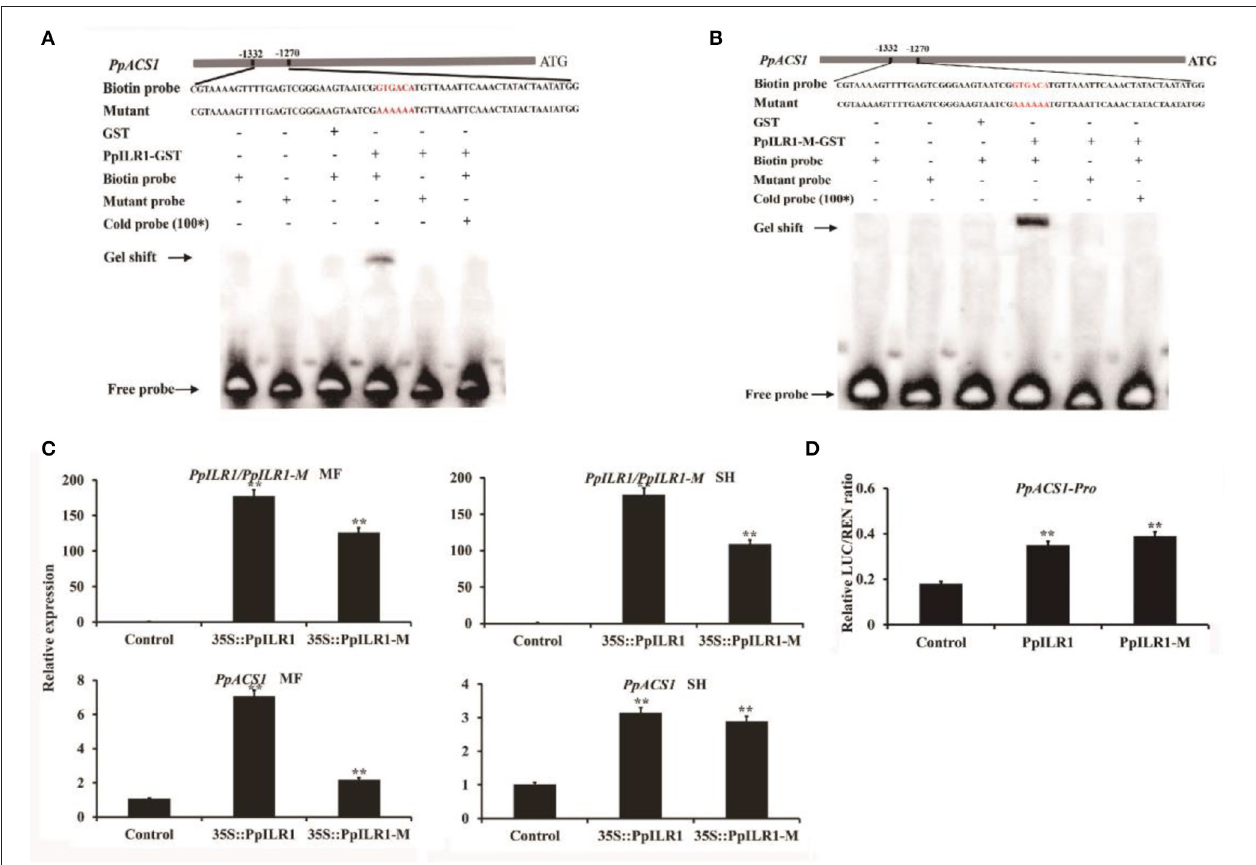
FIGURE 4 | PpILR1 and PpILR1-M activate transcription of PpACS1 . (A) Electrophoretic mobility shift assay (EMSA) showing that PpILR1 binds to the GTGACA motif in the PpACS1 promoter fragments, but not to the poly-A mutant fragment. (B) EMSA showing that PpILR1-M binds to the GTGACA motif in the PpACS1 promoter. (C) Transient overexpression of PpILR1 and PpILR1-M in MF- and SH-type peach fruits enhances the transcript levels of PpACS1 . Transcript levels of PpILR1 , PpILR1-M , and PpACS1 in peach fruit infiltrated with the empty vector (control), 35S::PpILR1, and the 35S::PpILR1-M vector. (D) Dual-luciferase reporter assay analysis showing that PpILR1 and PpILR1-M activate the promoter of PpACS1 . Agrobacterium tumefaciens harboring PpILR1 / PpILR1-M or PpACS1 promoter-driven firefly luciferase (LUC) reporter plasmids were infiltrated into tobacco leaves. Significantly higher LUC:REN ratios were obtained with the PpILR1 / PpILR1-M vector than with the empty vector, indicating that PpILR1/PpILR1-M increases PpACS1 promoter activity. Asterisks indicate significant differences (** P < 0.01; Student’s t -test).